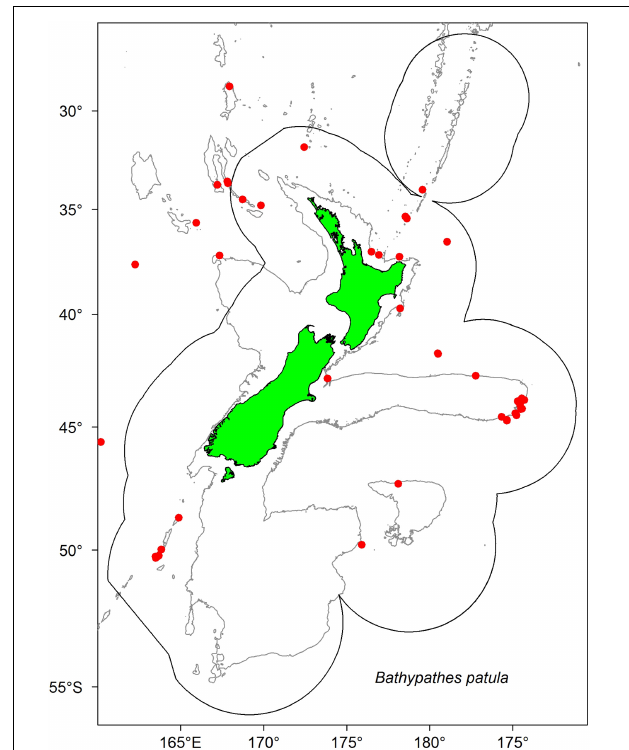
FIGURE 1 | Locations where Bathypathes patula has been sampled in the New Zealand region. Red dots denote individual coral sample source locations for B. patula specimens held in the National Invertebrate Collection of New Zealand (NIC). Gray lines denote 200 m water depth contour. Black line denotes the extent of the New Zealand Exclusive Economic Zone